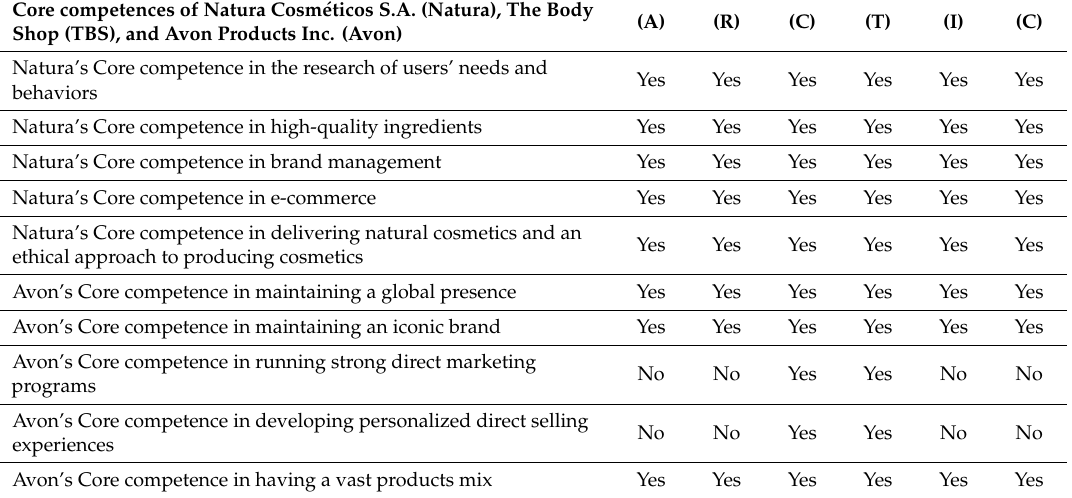
Table 8. ARCTIC framework for the pre-acquisition analysis of competence-based synergies (Natura’s acquisition of Avon Products